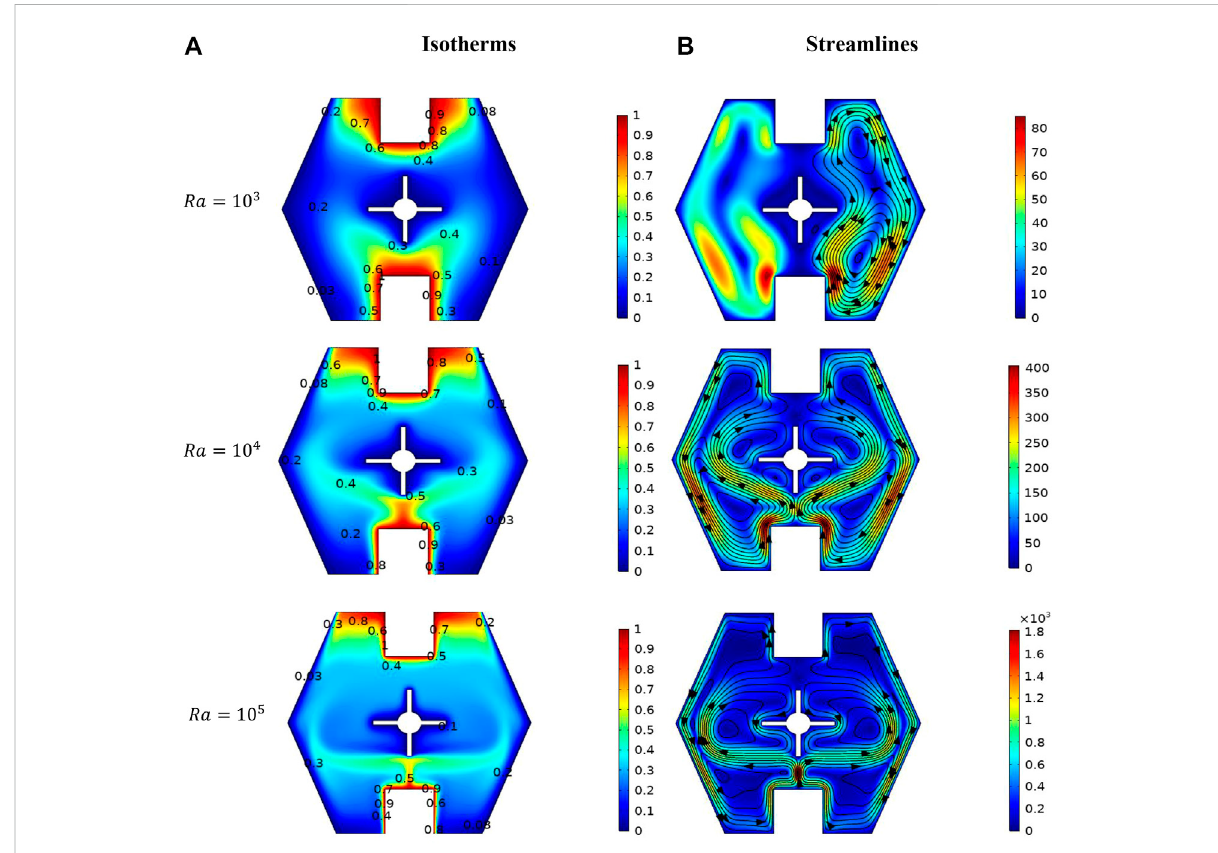
FIGURE 6 (A,B) Isotherms (left) and streamlines (right) for the variation in Ra at Pr (cid:2) 0 . 710 and Da (cid:2) 10 − 3 .